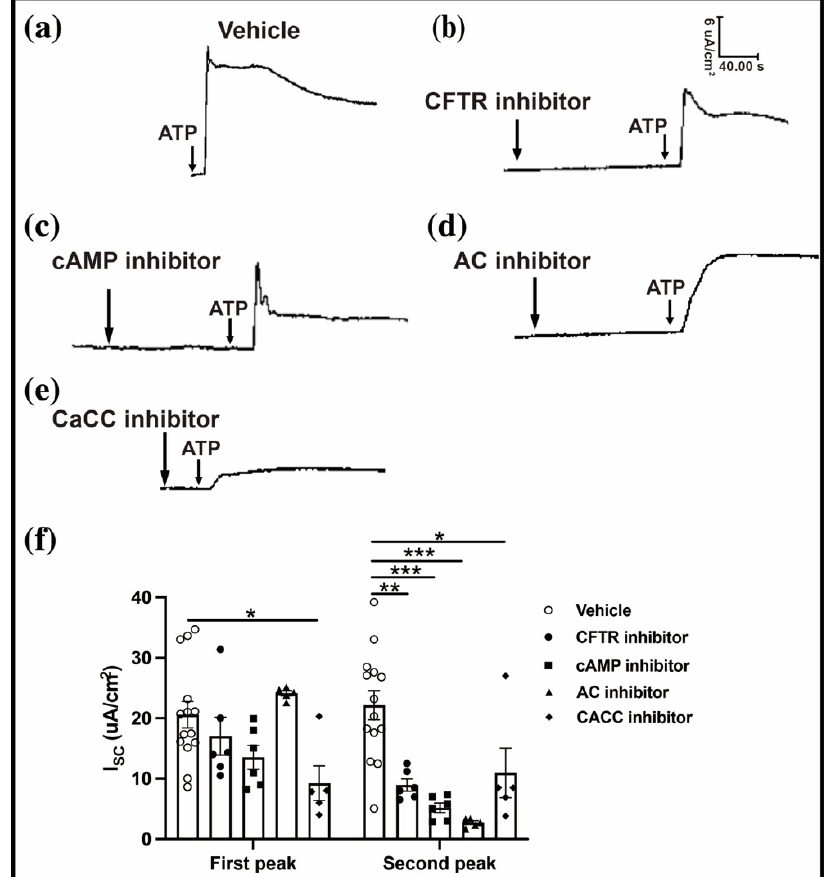
Figure 5. CaCC-CFTR pathway related to ATP-induced conjunctival Isc. ( a ) Representative image of ATP-induced conjunctival Isc in the vehicle group. ( b – e ) Representative image of ATP-induced conjunctival Isc using a special CFTR inhibitor (CFTR inh − 172 ), a special cAMP blocker (H 89 ), an AC inhibitor (MDL 12330A), and a special CaCC inhibitor (T16A inh − A01 ). ( f ) Bar graph showing the first and second peaks of ATP-induced conjunctival Isc in the vehicle group (n = 14), CFTR special inhibitor group (n = 6), AC inhibitor group (n = 5), and CaCC inhibitor group (n = 5). Data are represented as mean ± SEM. CFTR, cystic fibrosis transmembrane conductance regulator; AC, adenylyl cyclase; CaCC, Ca 2+ -activated Cl − channel. All results were compared with those of the control group. * p < 0.05, ** p < 0.01, *** p < 0.001.